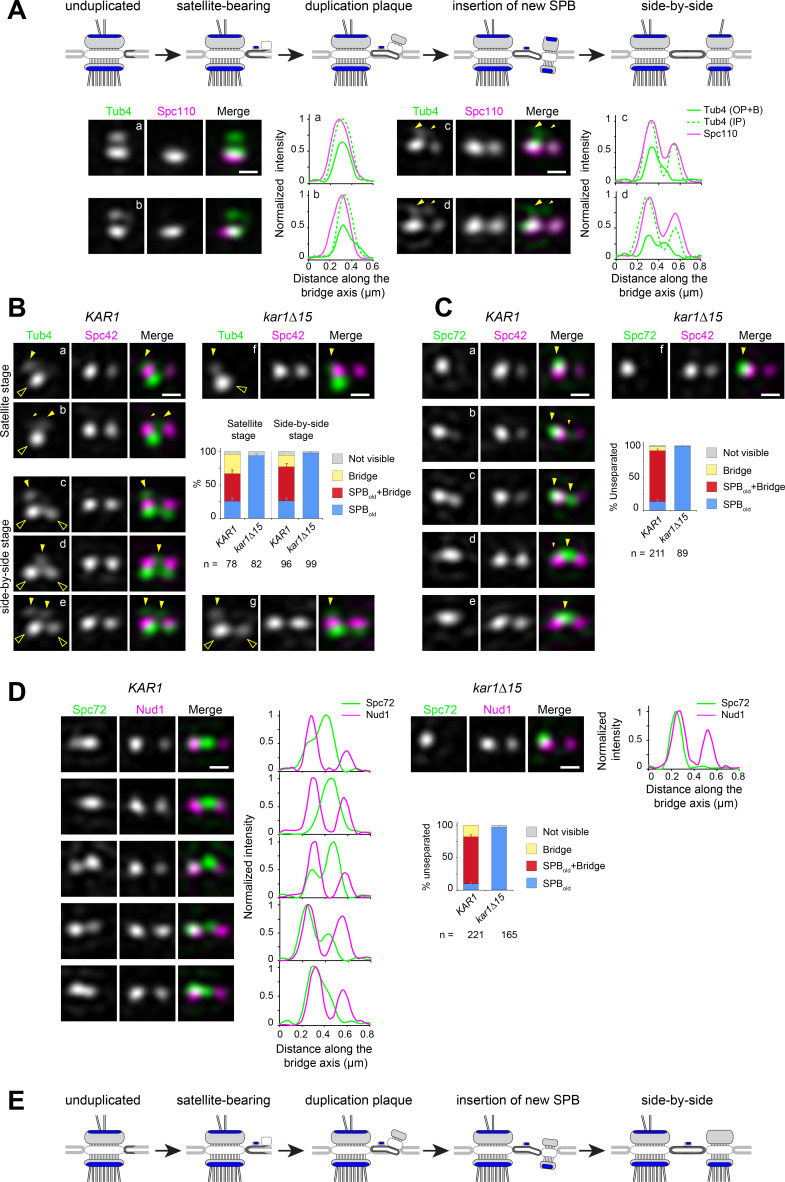
Spc72 and γTC are not added to the new SPB during its duplication.(A–D) SIM image projections were obtained after 3D-Gaussian fit and realignment using the indicated reference label. Images were rotated to position the old SPB to the left. Scale bar, 200 nm. (A) (top) Model for landmark events along the SPB duplication pathway deduced by EM and SIM studies (after Adams and Kilmartin, 1999 and Burns et al., 2015). The presumed localization of γTC according to this model is suggested in blue. (bottom) Representative SIM images and corresponding linescan analysis along the inner or outer plaque (1px-width, parallel to the bridge axis, internally normalized) illustrating Tub4-Venus distribution (green) relative to mT2-Spc110 (magenta). Images are ordered along the presumed SPB duplication pathway according to structures seen in early or intermediate steps of SPB duplication leading to the completed side-by-side SPBs: single SPB showing either a single (a) or extended (b) cytoplasmic label; (c–d) side-by-side stage. Big and small yellow arrowheads point to Tub4 at the old SPB outer plaque and bridge, respectively, as described in the text (B–C) Using Spc42-mT2 intensity, SIM images were organized to represent stages of SPB duplication. (B) The distribution of Tub4-Venus (green) localization relative to Spc42-mT2 (magenta) during SPB duplication in KAR1 (a–e) versus kar1∆15 (f–g) cells and plot for distribution of modes of Tub4 localization at the cytoplasmic face of the SPB. Solid yellow arrowheads point to sites on the cytoplasmic face of the SPB hollow arrowheads indicate inner plaque(s) (C) The distribution of Spc72-Venus (green) localization relative to Spc42-mT2 (magenta) during SPB duplication in KAR1 (a–e) versus kar1∆15 (f) cells and plot for modes of Spc72-Venus distribution at unseparated SPBs. Solid arrowheads mark dual localization of Spc72 as described in the text. Error bars, standard error of the proportion. (D) Spc72-Venus (green) and Nud1-mT2 (magenta) were localized in KAR1 versus kar1∆15 cells by SIM. Representative images of cells undergoing SPB duplication, paired to linescan analysis (three px-width along the bridge axis; internally normalized) and plot for distribution of modes of Spc72 localization relative to Nud1. Error bars, standard error of the proportion. (E) New model depicting the temporality for completion of inner and outer plaque assembly relative to other landmark events in the SPB duplication cycle as emerging from the data presented here. In particular, the new SPB outer plaque is incompletely assembled at the side-by-side stage, and thus unable to recruit γTC.